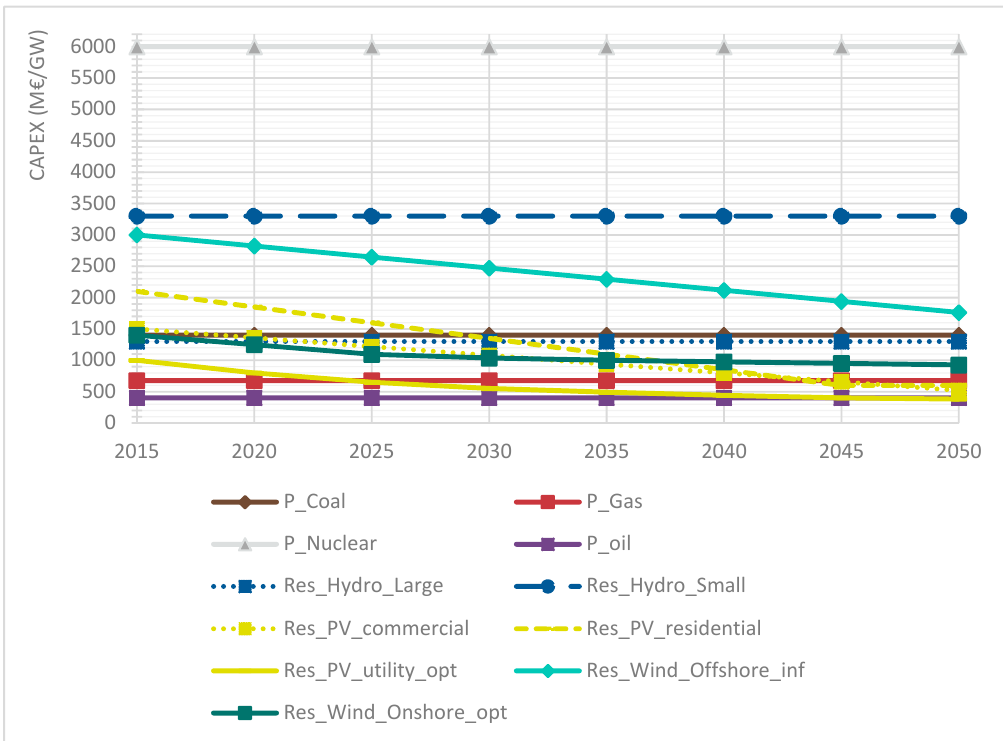
Figure A1. Capital Cost development of power-generating technologies.